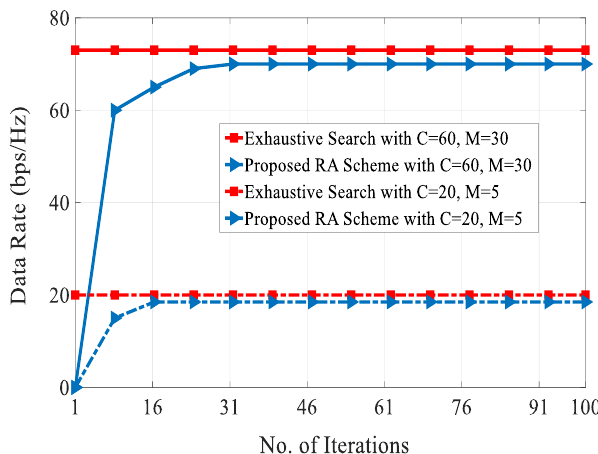
Figure 14. Data rate vs. no. of iterations.